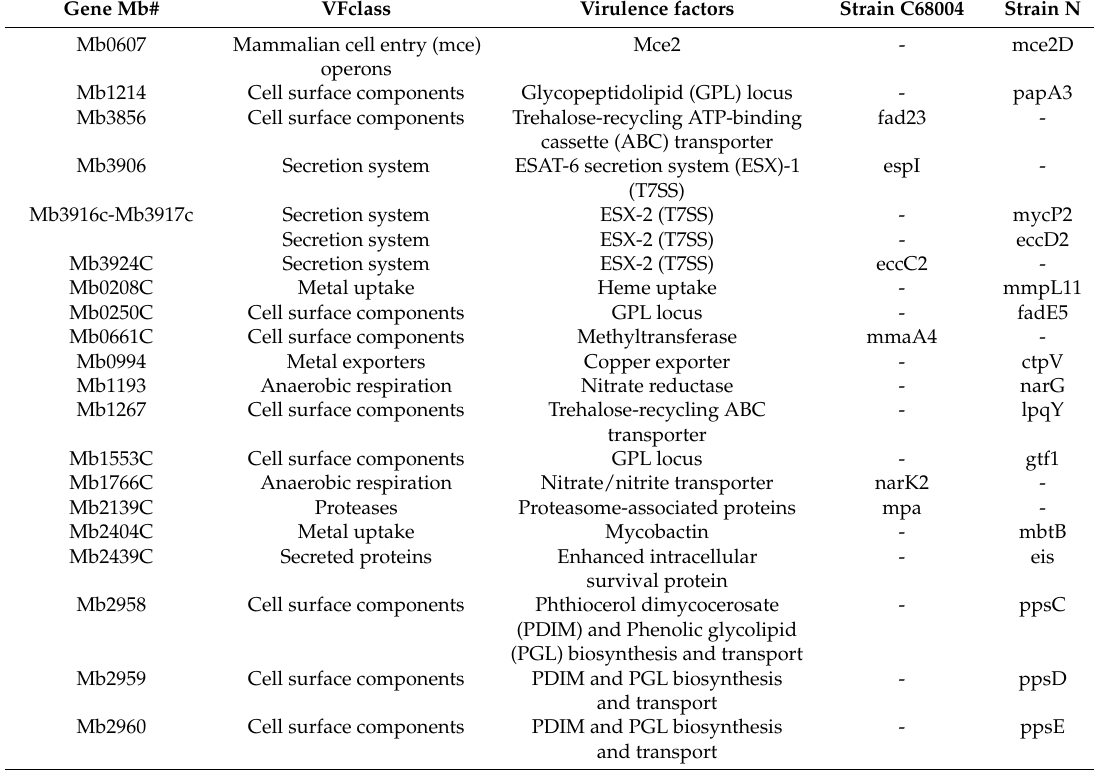
Table 2. Related genes of M. bovis C68004 and N